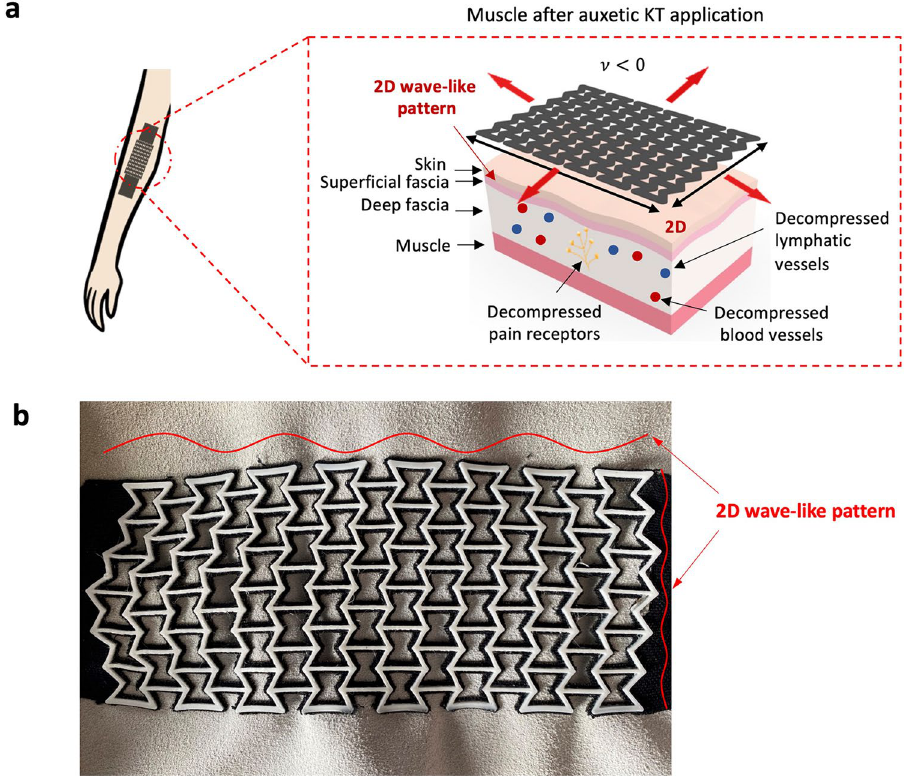
Figure 2. Novel auxetic KT ( a ) The positive decompressive effect generated by the auxetic KT application. A two-dimensional wave-like pattern is generated on the skin. Image inspired by 22–24 . ( b ) The two-dimensional wave-like pattern visible to the bare eye when a KT is applied on a leather sample used to mimic the